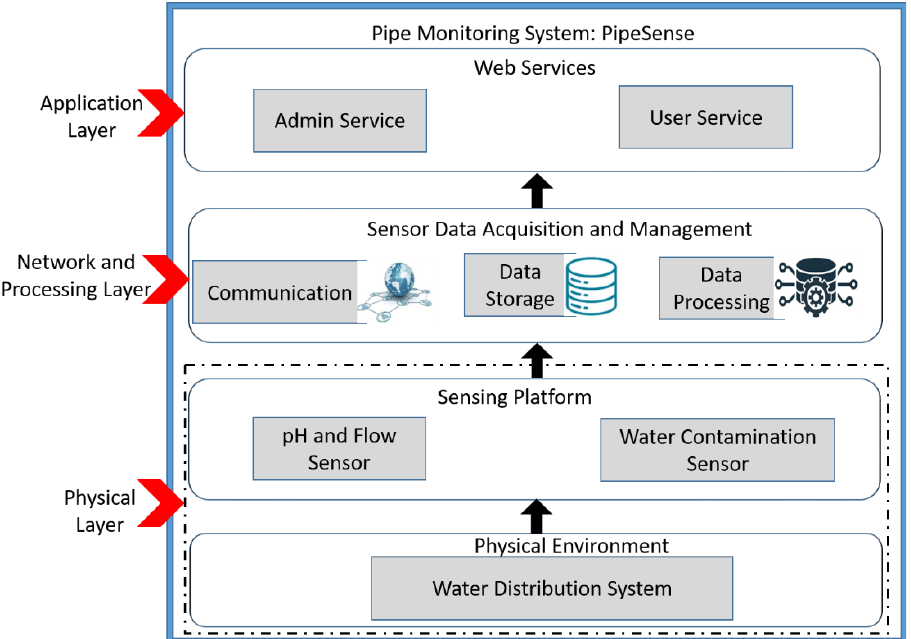
Figure 6. Architectural framework for in-pipe water monitoring system [50].